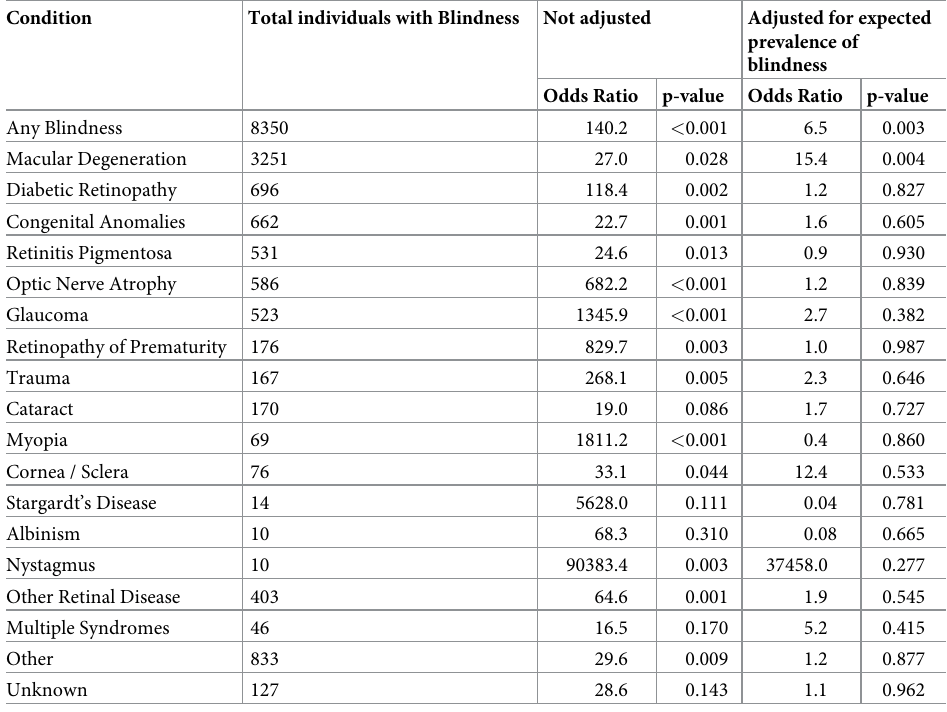
The number of persons with blindness due to various causes, and odds ratios for the change in prevalence of blindness (per 1000 persons in the county) associated with one more ophthalmologist per 1000 persons. The first model shows univariate odds ratios; the second model shows the odds ratio after adjusting for expected prevalence of blindness based on the multivariable model